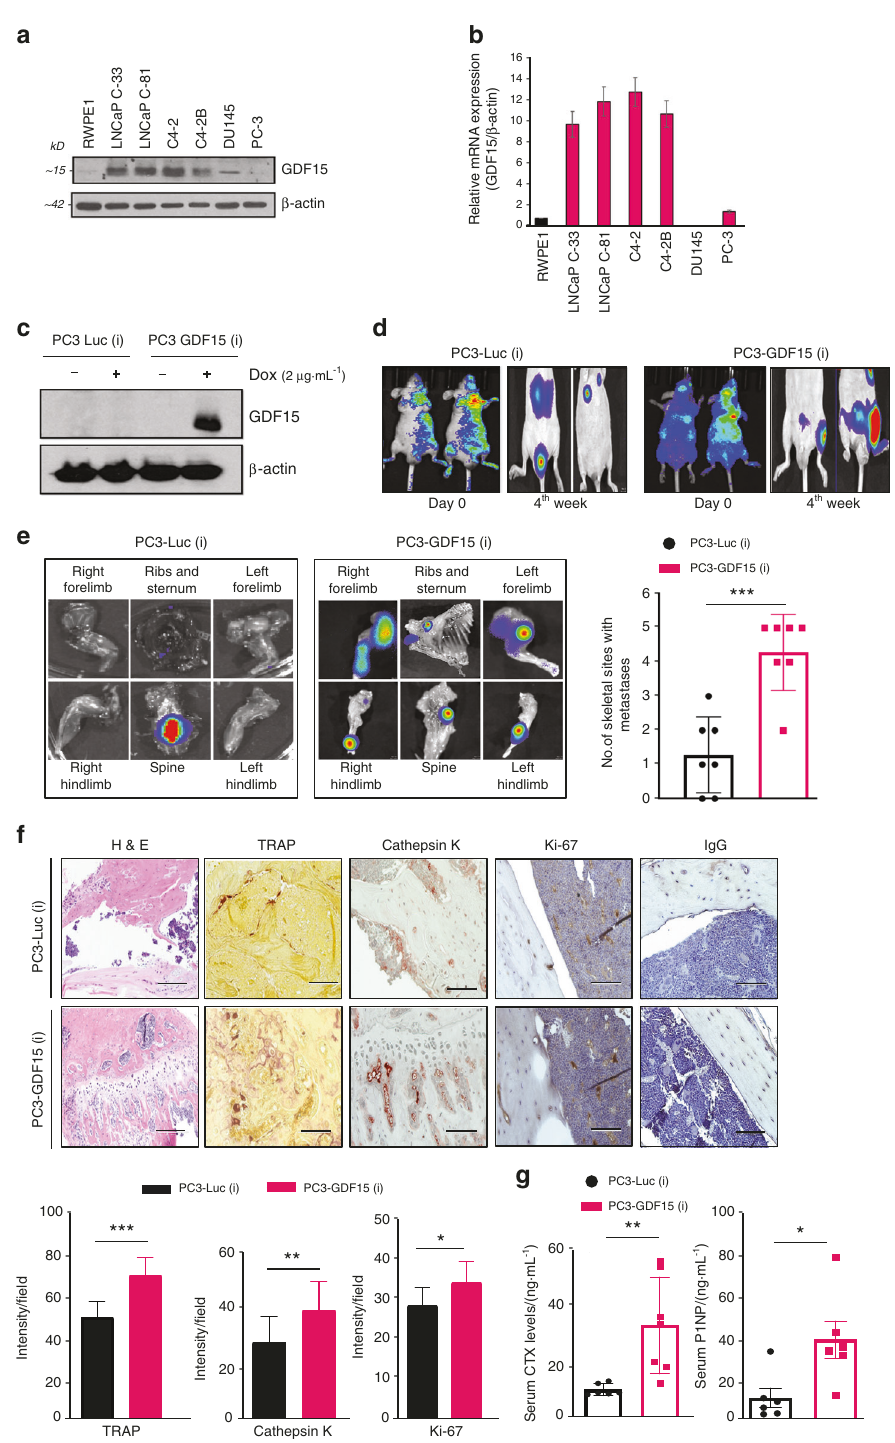
Fig. 1 GDF15 promotes PCa bone metastasis. a Expression of GDF15 protein in human PCa cell lines as indicated by Western blot analysis. b The expression of GDF15 at the transcriptional level was analyzed by RT – qPCR analysis in human PCa cell lines. c Western blot analyses to determine GDF15 expression in the lysates of PC3-Luc(i) and PC3-GDF15(i) cells after 48 h of doxycycline (Dox) induction. d Representative photographs of mice injected with PC3-Luc(i) and PC3-GDF15(i) cells to detect bone metastasis after Dox treatment at the indicated time points using IVIS imaging. e Representative ex vivo images of excised tissues from different skeletal sites after fi nal in vivo imaging within 10 min of luciferin injection (bioluminescent images of the ribs and sternum, spine, forelimbs, and hind limbs) (left panel) and quanti fi cation of the number of skeletal sites with metastasis in mice injected with PC3-Luc(i) and PC3-GDF15(i) (right panel) . f Histopathological staining of excised bone sections of PC3-Luc(i)- and PC3-GDF15(i)-injected mice. (Upper panel) Representative H&E staining and TRAP (osteoclast marker) staining of bone. Bone sections were immunostained for cathepsin K (a functional marker for bone resorption) and Ki67 and subjected to corresponding IgG staining. (Lower panel) Quanti fi cation of TRAP, cathepsin K and Ki67 staining. Bone marker analysis in serum obtained from PC3-Luc(i)- and PC3-GDF15-injected mice. Scale bar = 400 µm. g Serum CTX and P1NP were measured to assess bone turnover ( n = 6 mice/group). The data are given as the mean ± SEM, and P ≤ 0.05 was considered to indicate statistical signi fi cance. * P < 0.05, ** P <0.01, * ** P <0.001 compared to the PC3-Luc(i)-injected